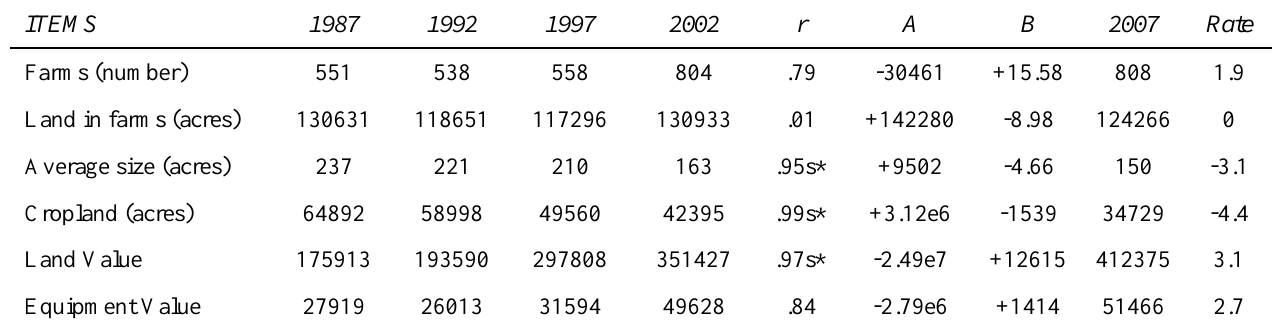
Table 2c: Rankin County Regression